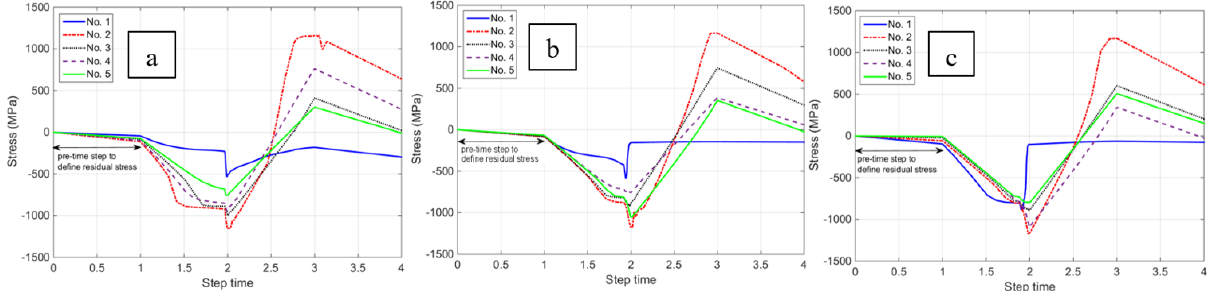
Figure 21. Behavior of different elements located close to and far from the crack for three magnitudes of peak stress: ( a ) − 1.05 s y , ( b ) − 1.1 s y , ( c ) − 1.15 s y .